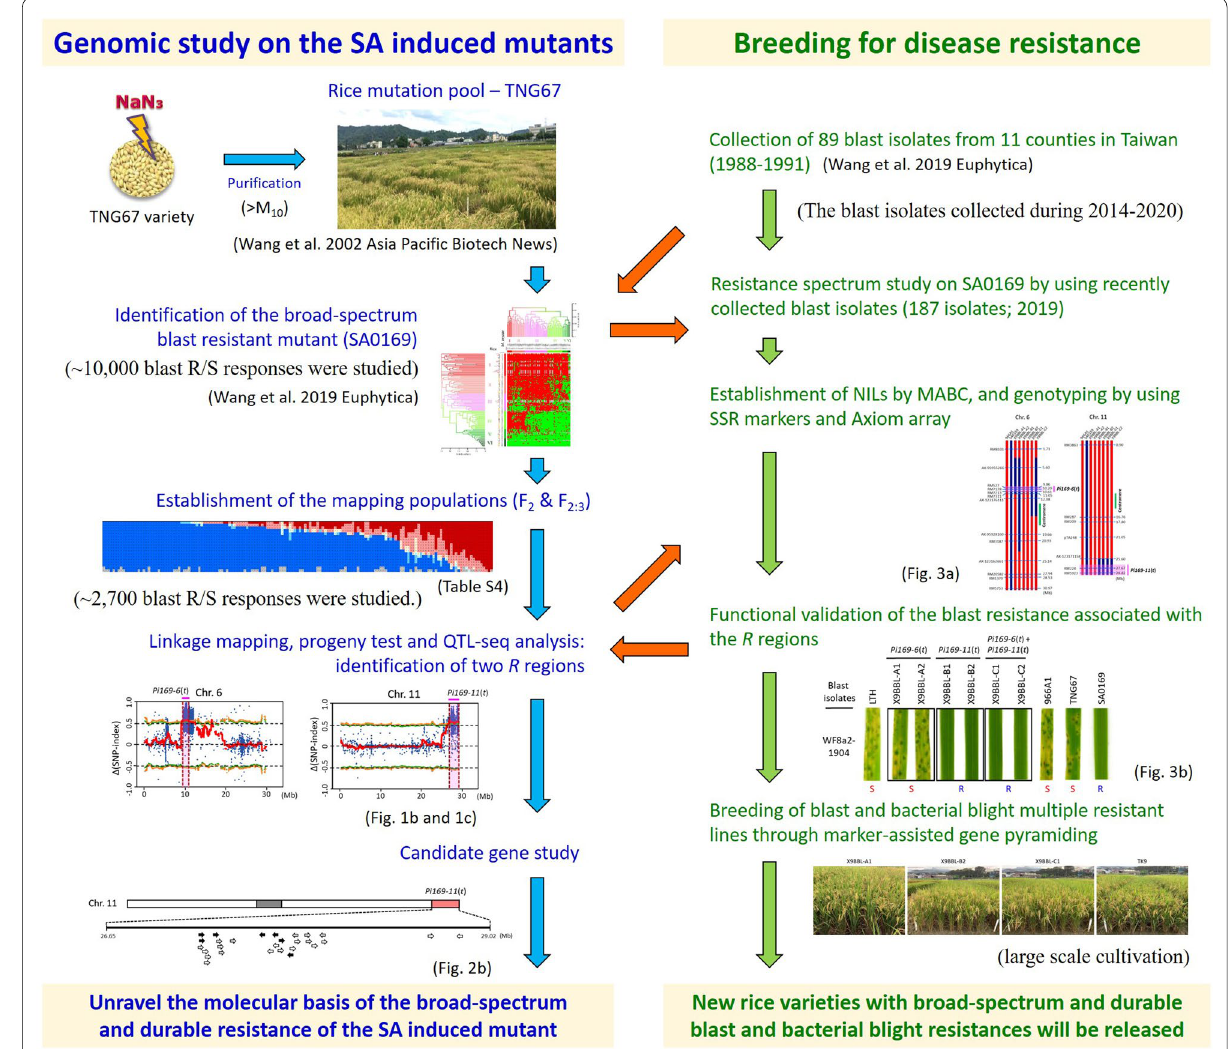
Fig. 4 Overview of the genomic study and disease resistance breeding using the blast resistant mutant SA0169. Left panel is the flowchart of genomic study in SA0169. The procedure of combining the progeny test and QTL‑seq accelerated the mapping process of the blast resistance associated regions in SA0169. Right panel is the steps of breeding resistant lines, which included the selection of a bacterial blight resistant line as the recurrent parent, and the establishment of NILs through MABC with the mapping results. The developed lines can be used as disease resistance donors for BL and BB, and are ready to be released to farmers. This study provides an example for the combination of a genomic study on a SA induced mutant and breeding for disease resistance. BL, blast; BB, bacterial blight; SA, sodium azide; NILs, near isogenic lines; MABC,